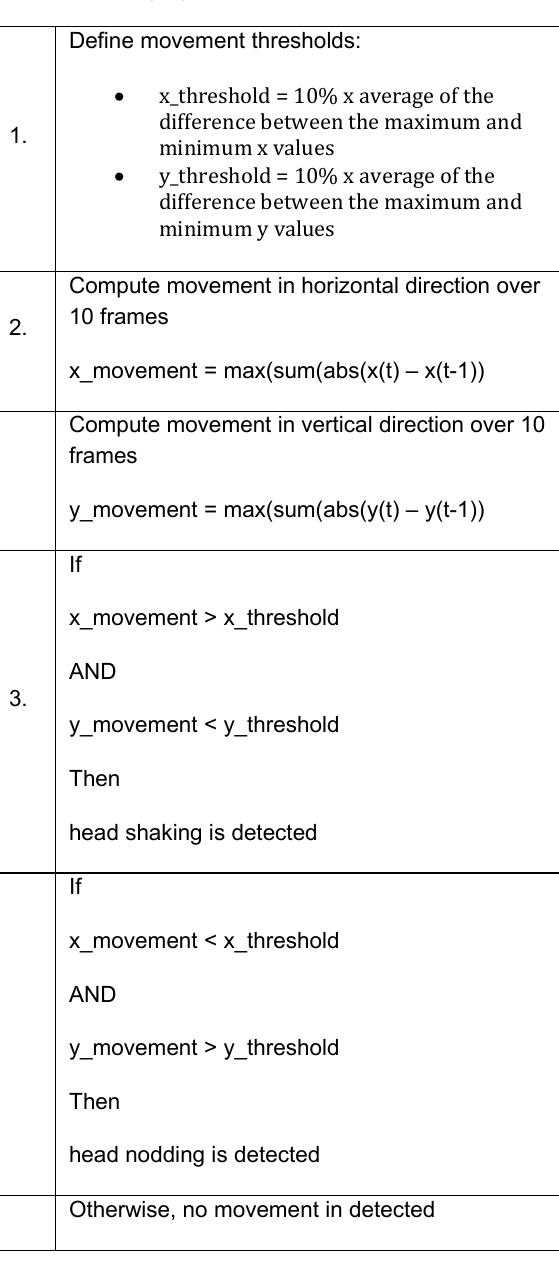
Table 1 | Algorithm to detect head movement.